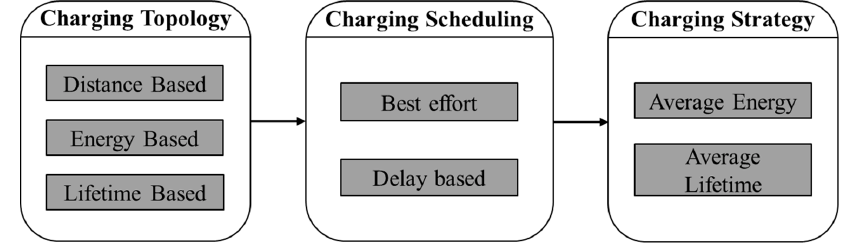
Figure 4. The schematic diagram of MMCS.